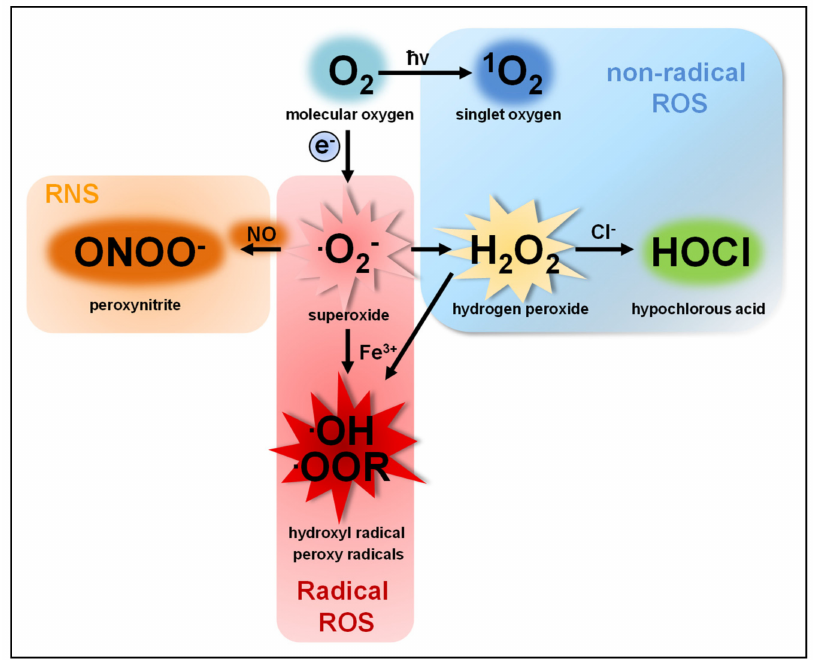
Figure 1. Reduction of O 2 generates O 2 •− , which acts as precursor for all other ROS subspecies produced by cells. O 2 •− quickly dismutates to H 2 O 2 . H 2 O 2 can be converted enzymatically by myeloperoxidase (MPO) to OCl − or by ferric iron (Fe 3+ ) to • OOR or • OH. The oxidation of H 2 O 2 by Fe 3+ is called Fenton reaction [1] resulting in • OH as reactive intermediate [2], however, this reaction rarely takes place in cells [3]. Similarly, the excitation of O 2 to 1 O 2 by radiation (¯ h v) rarely takes place in animals [4,5]. Of note, nitric oxide (NO) and peroxynitrite (ONOO − ) are reactive nitrogen species (RNS) and not